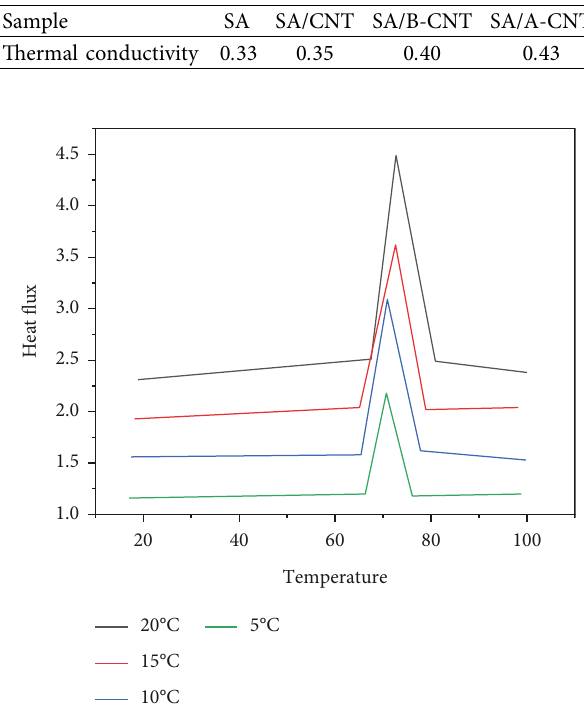
Figure 4: DSC curves of pure SA at different heating rates.